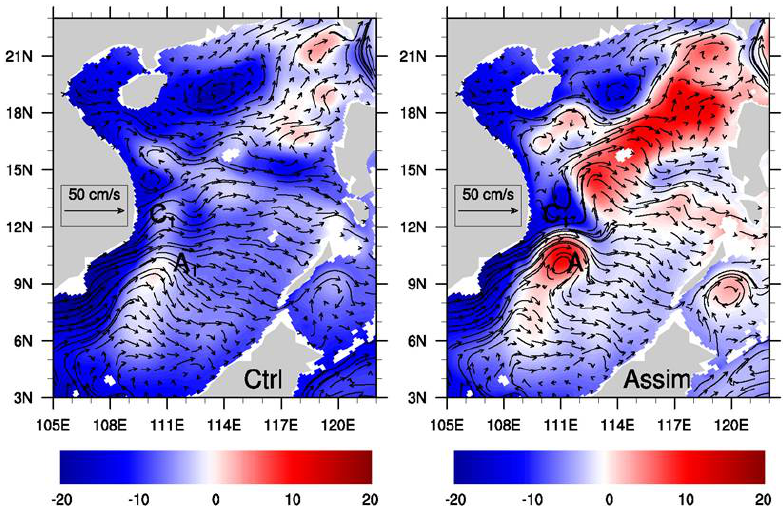
Fig. 10. Comparison of the monthly surface currents (black arrows) and SLA (shaded colors) in July 1994 for the control run (Ctrl, left) and the assimilation run of (Assim, right). Note: A 1 and C 1 respectively denote the positions of the anticyclonic and cyclonic eddies in July 1994 from Wang et al. (2003).